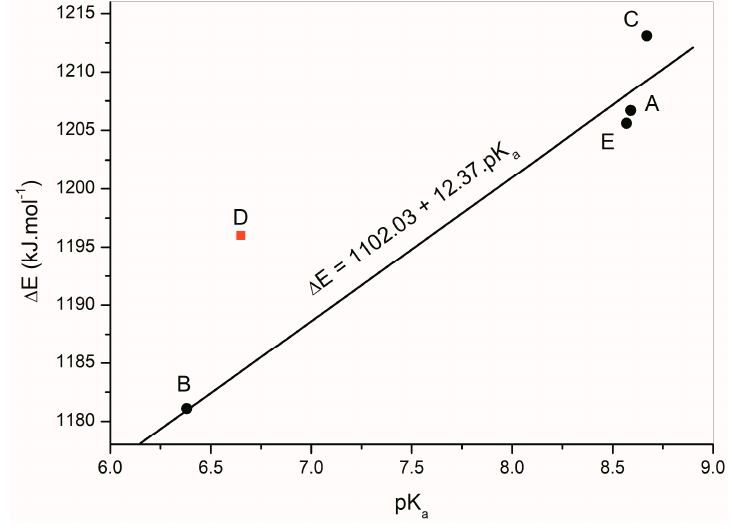
Figure 9. Linear dependence of the calculated deprotonation energies of A – E determined from experimental p K a values of isatin derivatives.